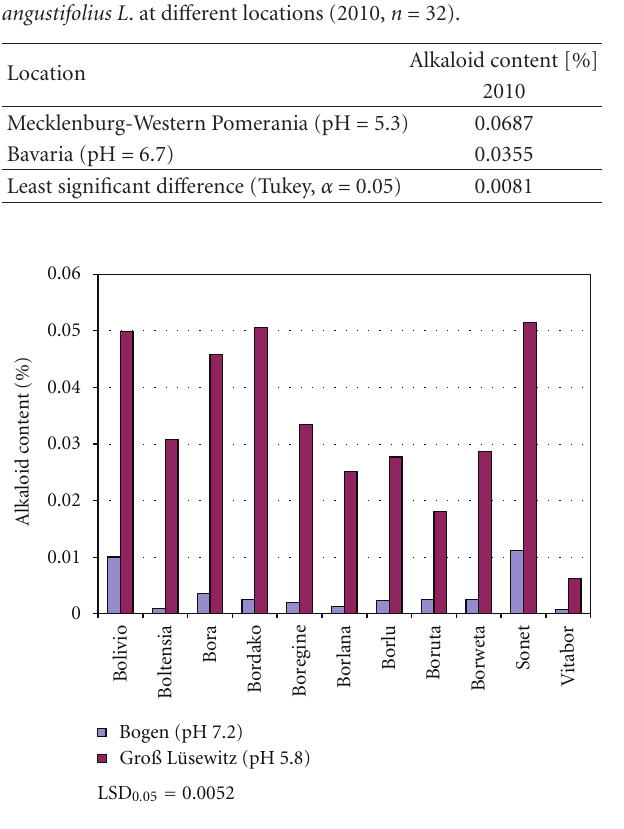
Figure 2: Influence of the soil pH on the main alkaloid content of Lupinus angustifolius (mean of 2004 and 2005).